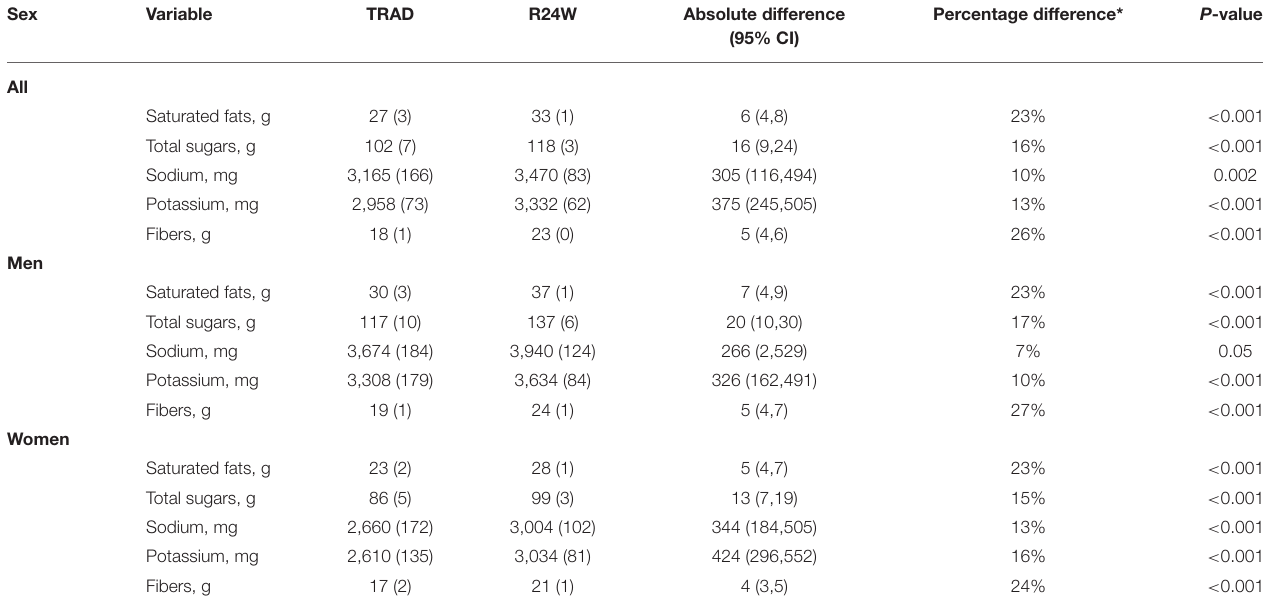
TABLE 3 | Mean absolute nutrient intakes using an interview-administered 24-h recall (TRAD) and a web-based 24-h recall (R24W) in population-based samples of French-speaking adults from Quebec, Canada.